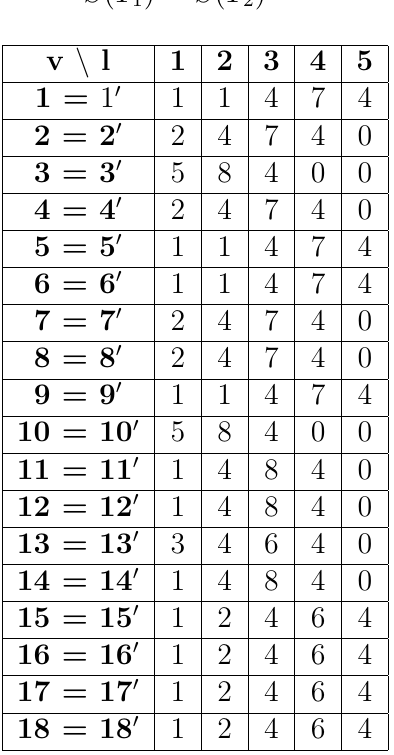
Table 1: The Randi´c-table 𝑆 ( 𝑇